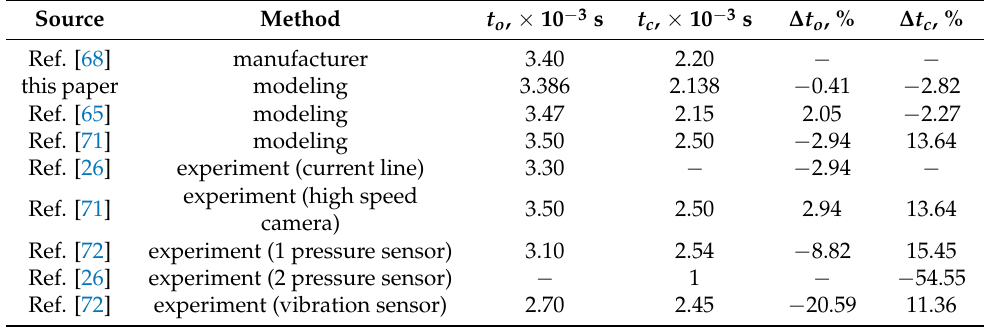
Table 4. Comparison of Valtek Rail Type-30 injector opening and closing